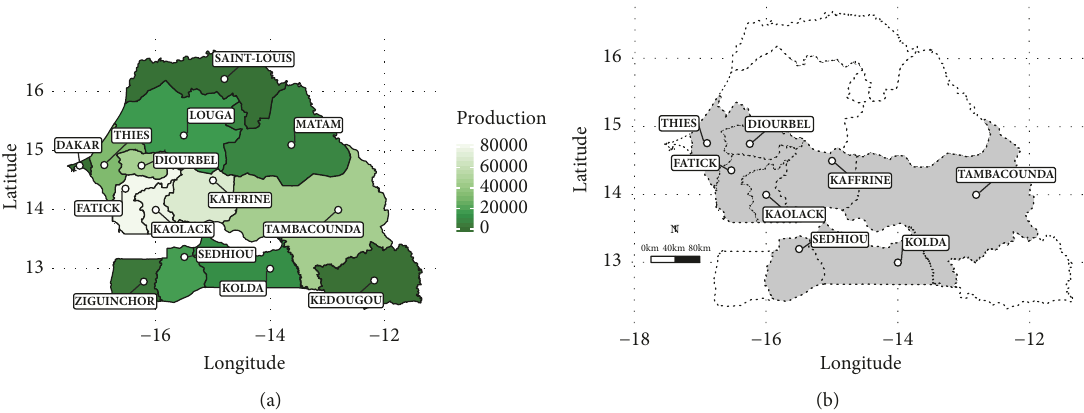
Figure1:Mapshowingproduction(ton)ofpearlmilletinregionsofSenegalduringagriculturalcampaign2014-2015:(a)gray-coloredregions representing on-farm surveyed ones (production ≥ 15000 tons) during rainy season 2017 (b).